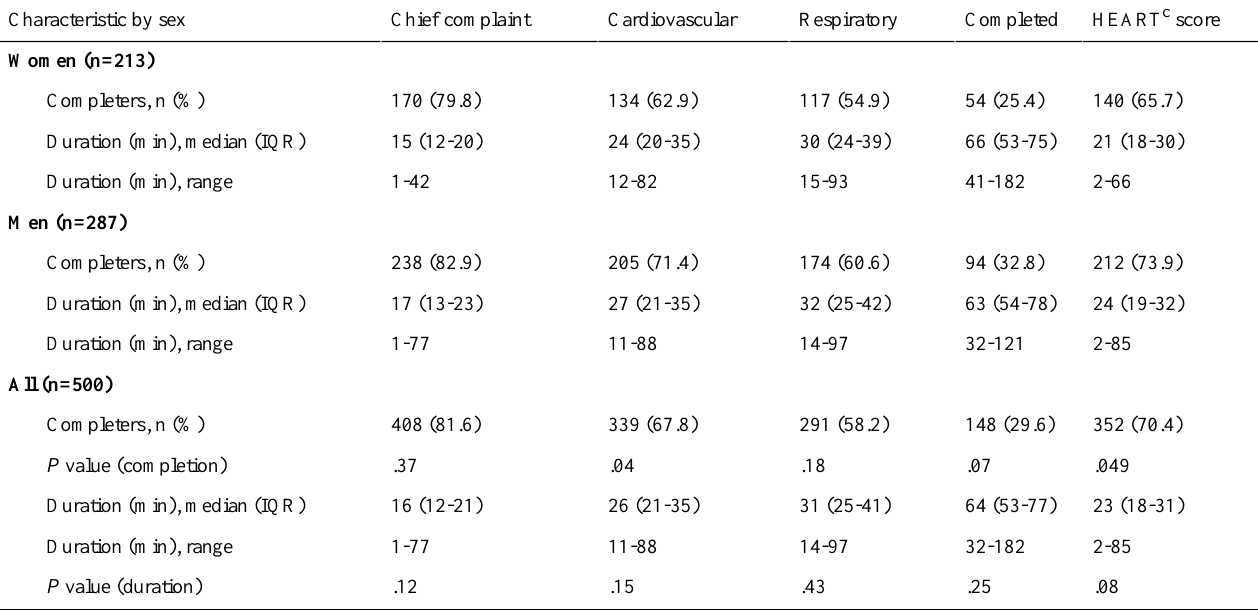
Table 3. Summary table for completion and duration of key modules, HEART score, and completed interview. a,b